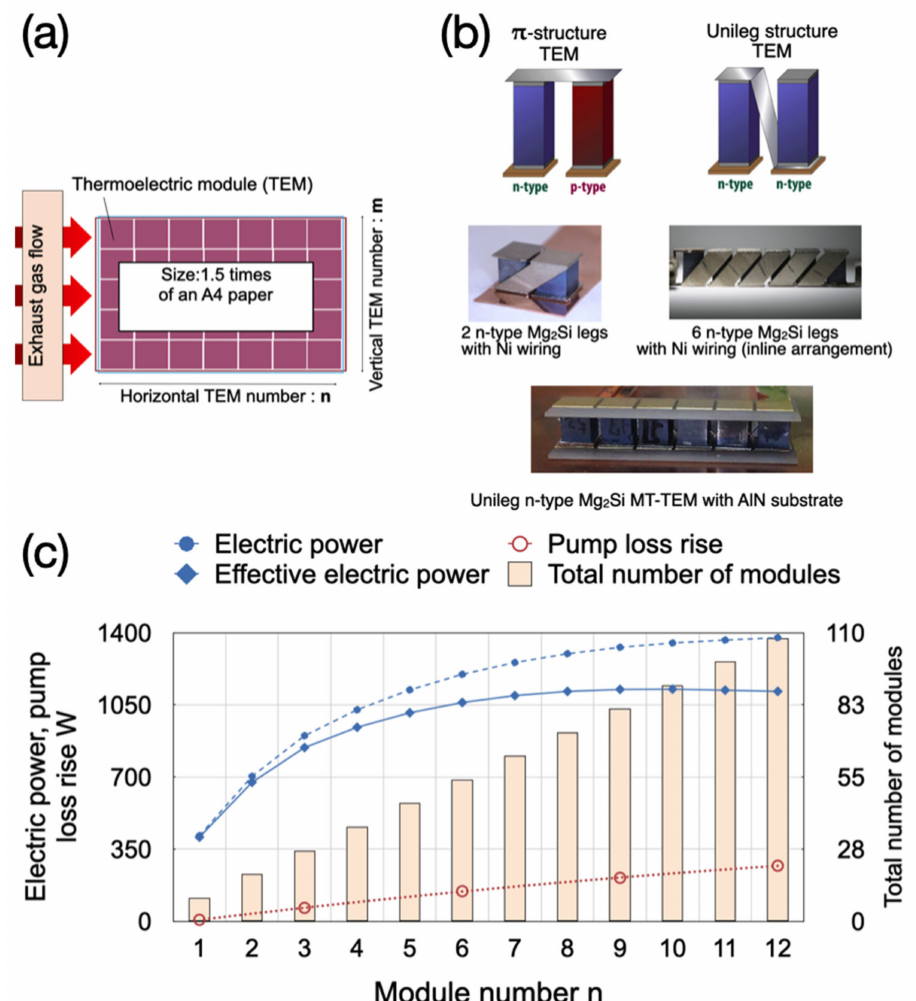
Figure 12. ( a ) Layout of the thermoelectric generation module; ( b ) basic structure of used unileg Mg 2 Si MT-TEM; ( c ) relationship between the total amount of power generated by the waste heat power generation unit, the number of rows of TEMs, and the pump loss (gasoline